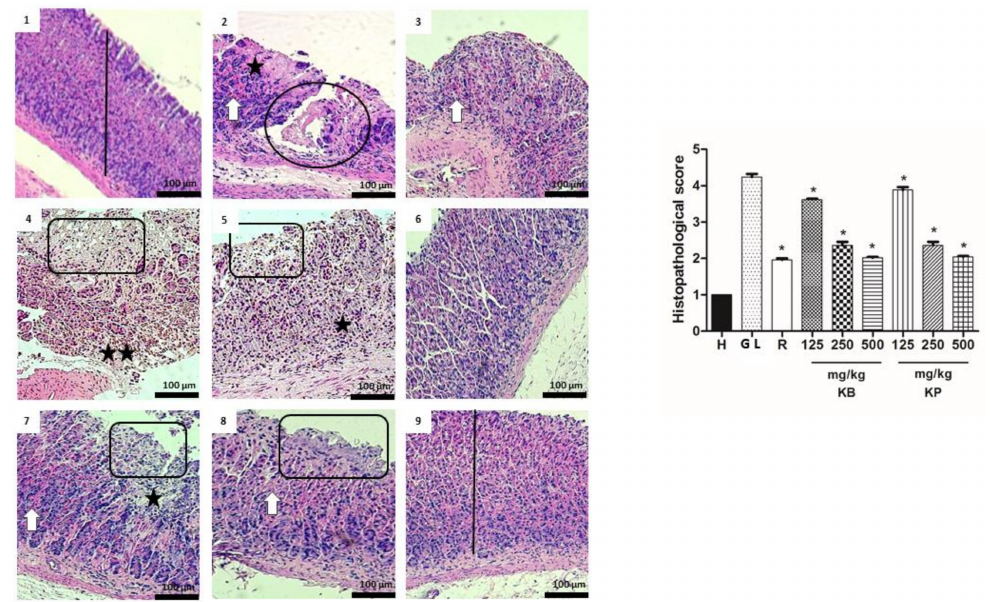
Figure 7. Effect of pre-treatment with K. brasiliensis and K. pinnata leaf juice (125, 250 and 500 mg/kg) on the histology of indomethacin-induced gastric mucosal damage in rats. Histopathological characteristics of the gastric tissue of rats, showing the cut of the stomach in the longitudinal direction. (1) Healthy; (2) Gastric lesion control; (3) Ranitidine; (4) K. brasiliensis 125 mg/kg; (5) K. brasiliensis 250 mg/kg; (6) K. brasiliensis 500 mg/kg; (7) K. pinnata 125 mg/kg; (8) K. pinnata 250 mg/kg; (9) K. pinnata 500 mg/kg. The bar indicates gastric mucosa without changes; Two asterisks: intense inflammatory infiltrate; One asterisk: weak inflammatory infiltrate; Circle: destruction of mucosal layer; White arrow: congestion of blood vessels; Rectangle: necrotic lesions. Data expressed as mean ± standard mean error, ( n = 5). Mann–Whitney used to calculate statistical significance, * p < 0.05 vs. gastric lesion control. Healthy, H; Gastric lesion control, GL; Ranitidine, R. K. brasiliensis , KB; K. pinnata , KP.